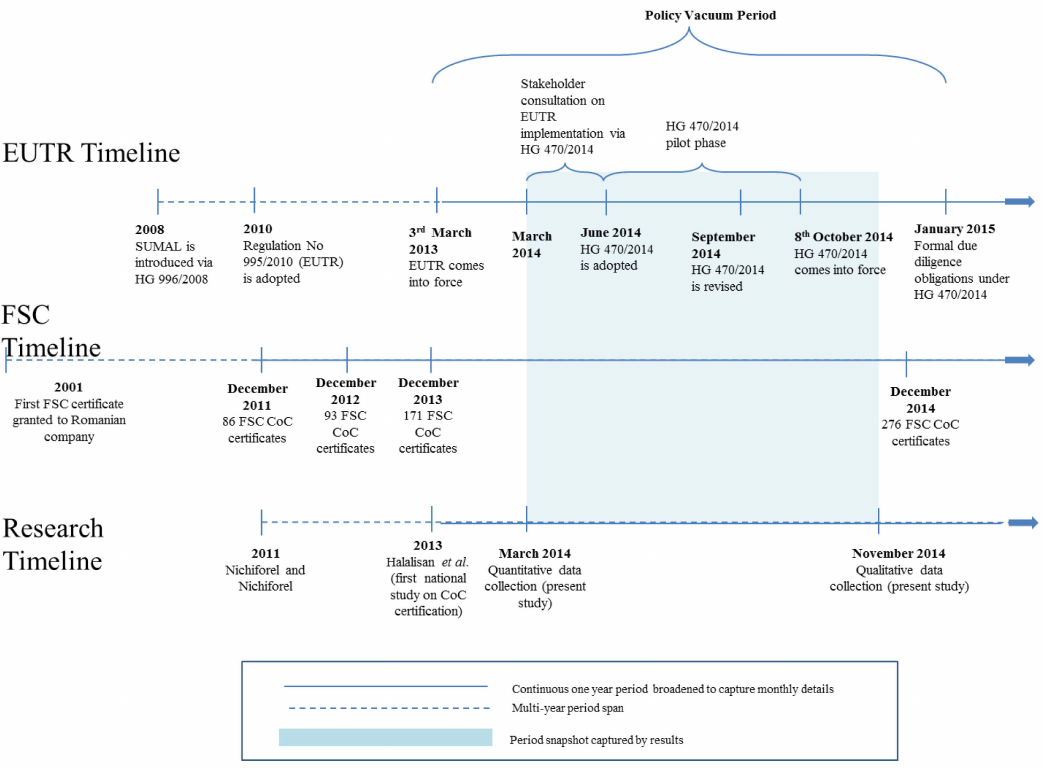
Figure 2. Different timelines and the policy vacuum period in EUTR